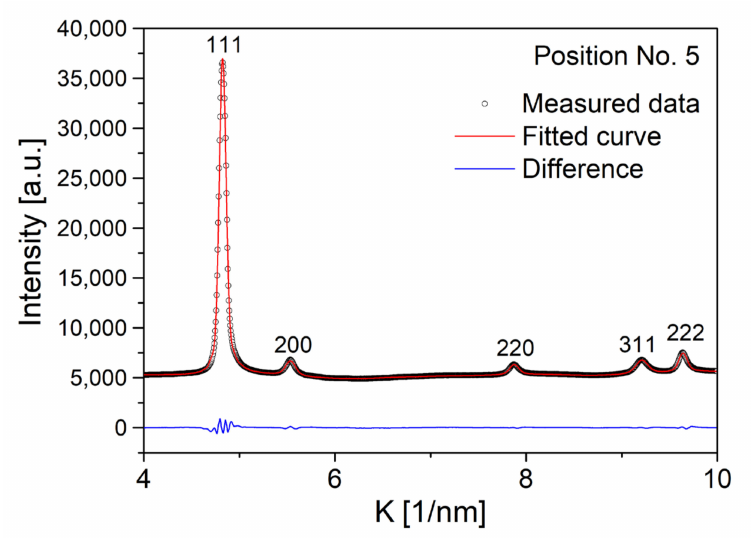
Figure 5. CMWP fitting for the first five XRD peaks of the fcc phase at point No.